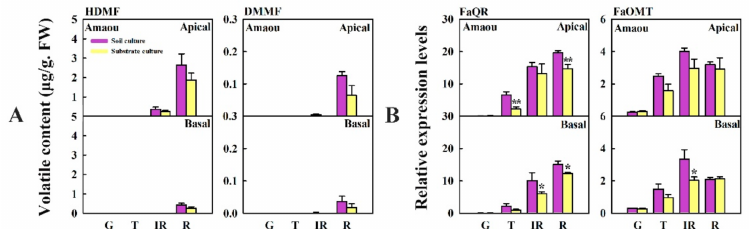
Figure 3. Analysis of furanone content ( A ) and expression of FaQR and FaOMT ( B ) in ‘Amaou’ strawberry fruits. Bars stand for means ± SD from three biological replicates. Asterisks indicate significant differences (* p < 0.05; ** p <